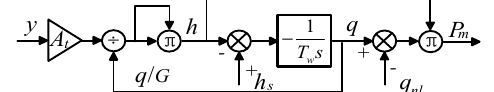
Figure 6. Simplified nonlinear turbine model.